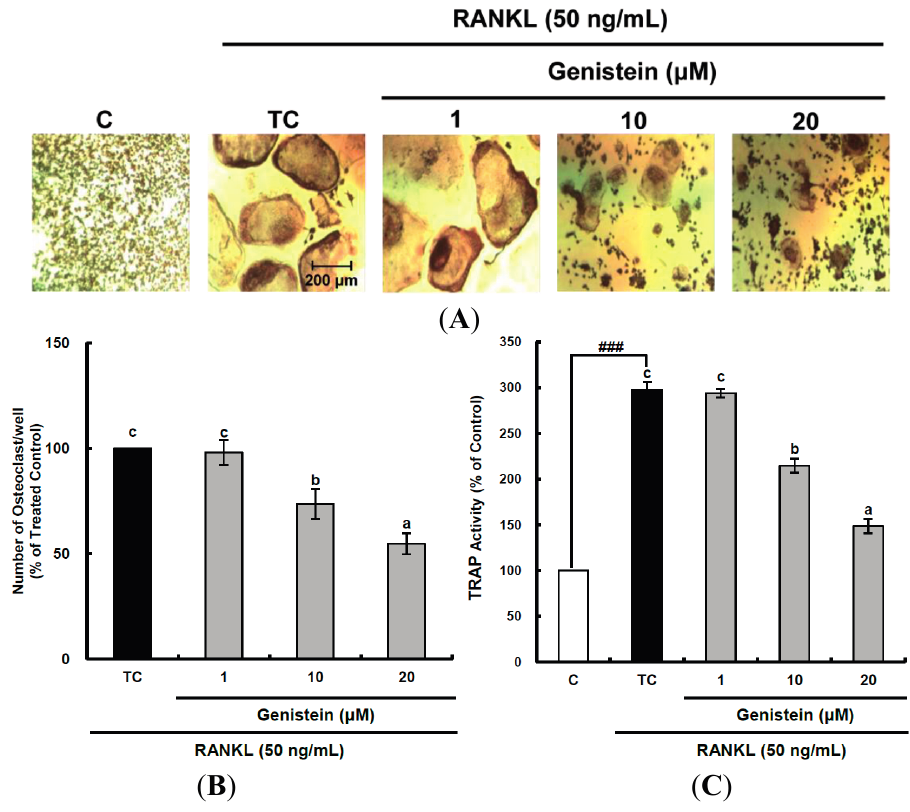
Figure 2. Inhibitory effects of genistein on differentiation ( A , B ) and tartrate-resistant acid phosphatase (TRAP) activity ( C ) of osteoclastic RAW 264.7 cells. RAW 264.7 cells were exposed to the receptor activator of nuclear factor kappa-B ligand (RANKL) (50 ng/mL) for five days in the absence and the presence of genistein. After five days in culture, the cells were fixed and stained using a leukocyte acid phosphatase kit. TRAP-positive multinucleated osteoclasts were visualized under light microphotography ( A ); TRAP-positive multi-nucleated osteoclasts were counted ( B ). Data are expressed as the percentages of the value of cells treated with RANKL (means ± standard deviations (SD), n = 3); TRAP activity was measured at λ = 405 nm ( C ). Data are expressed as percentages of the values of untreated cells (means ± standard deviations, n = 3). Different corresponding letters indicate significant differences at p < 0.05 by Duncan’s test. ### p < 0.001 vs. C